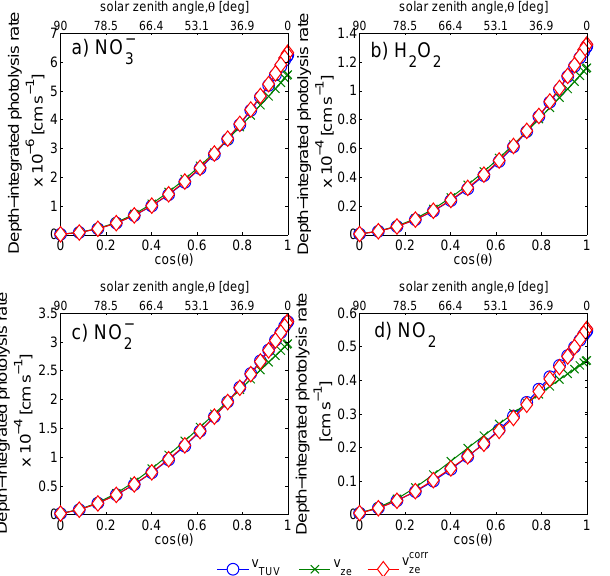
Figure 7. Depth-integrated photolysis rate coefficient at various solar zenith angle for different species within snowpack BaseC ( ρ = 0.4gcm − 3 , [BC] = 4ng ( C ) g − 1 and σ scatt = 25m 2 kg − 1 ). (a) Depth-integrated photolysis rate coefficient of the NO − (b) depth-integrated photolysis rate coefficient of H 2 O 2 ; (c) depth- integrated photolysis rate coefficient of the NO − integrated photolysis rate coefficient of NO 2 ; blue circle – v TUV , computed by TUV; green cross – v z depth method; pink diamond – v Corr z listed in Table 4.